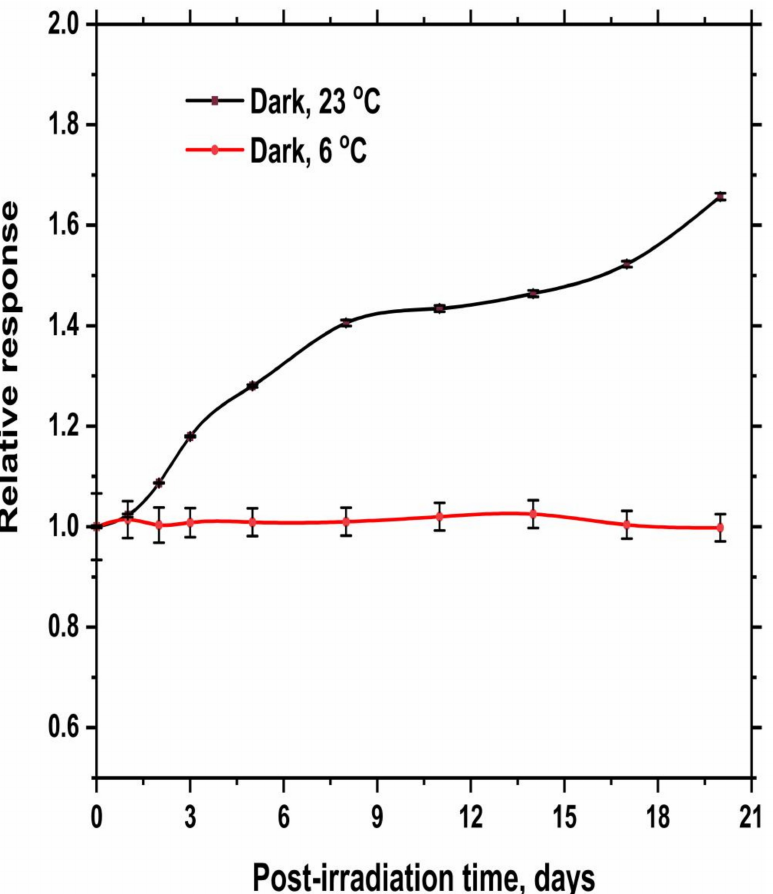
Figure 8. Relative response of irradiated hydrogel dosimeter (100 mM AgNO 3 and 0% Glycerol) to the response measured immediately after irradiation (zero time) as a function of storage time. The hydrogel dosimeters were irradiated at 50 Gy and then stored in a dark place at different temperatures (6 ◦ C and RT, 23 ◦ C). The solid lines are a guide for the eye obtained using a basis spline